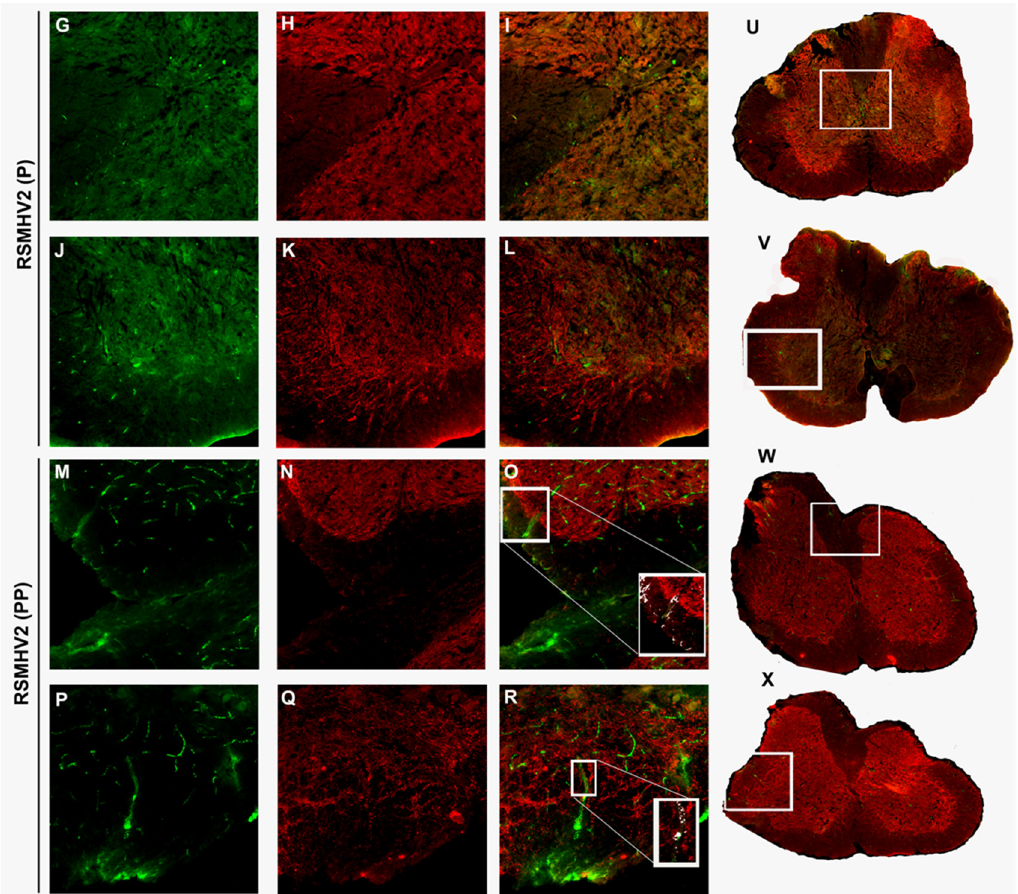
Figure 8. Colocalization of viral antigen with neuronal microtubule marker (MAP2) of RSA59 (PP), RSMHV2 (P), and RSMHV2 (PP) infected spinal cord cryosections . Day 5 post-infected spinal cord cryosections immuno-fluorescently labeled with MAP2 (Red) ( B , E , H , K , N , Q ). Intrinsic EGFP fluorescence denotes viral antigen ( A , D , G , J , M , P ). Merged images of EGFP and MAP2 ( C , F , I , L , O , R ). RSA59 (PP) infected spinal cord sections are ( A – F , S , T ), RSMHV2 (P) are from ( G – L , U , V ), RSMHV2 (PP) are ( M – R , W , X ). Dorsal column gray-white matter junctions are in panels ( A – C ) (RSA59 (PP)), ( G – I ) (RSMHV2 (P)), and P-R (RSMHV2 (PP)). The ventral white matter and adjacent ventral horns from the infected section are shown as RSA59 (PP) ( D , F ), RSMHV2 (P) ( J – L ), RSMHV2 (PP) ( P – R ). The insets in the merged images show magnified views of the co-localization of virus-infected cells with the Anti-MAP2 and dendrites at the gray-white matter junction. In the insets, co-localization is seen as white with infected axons.